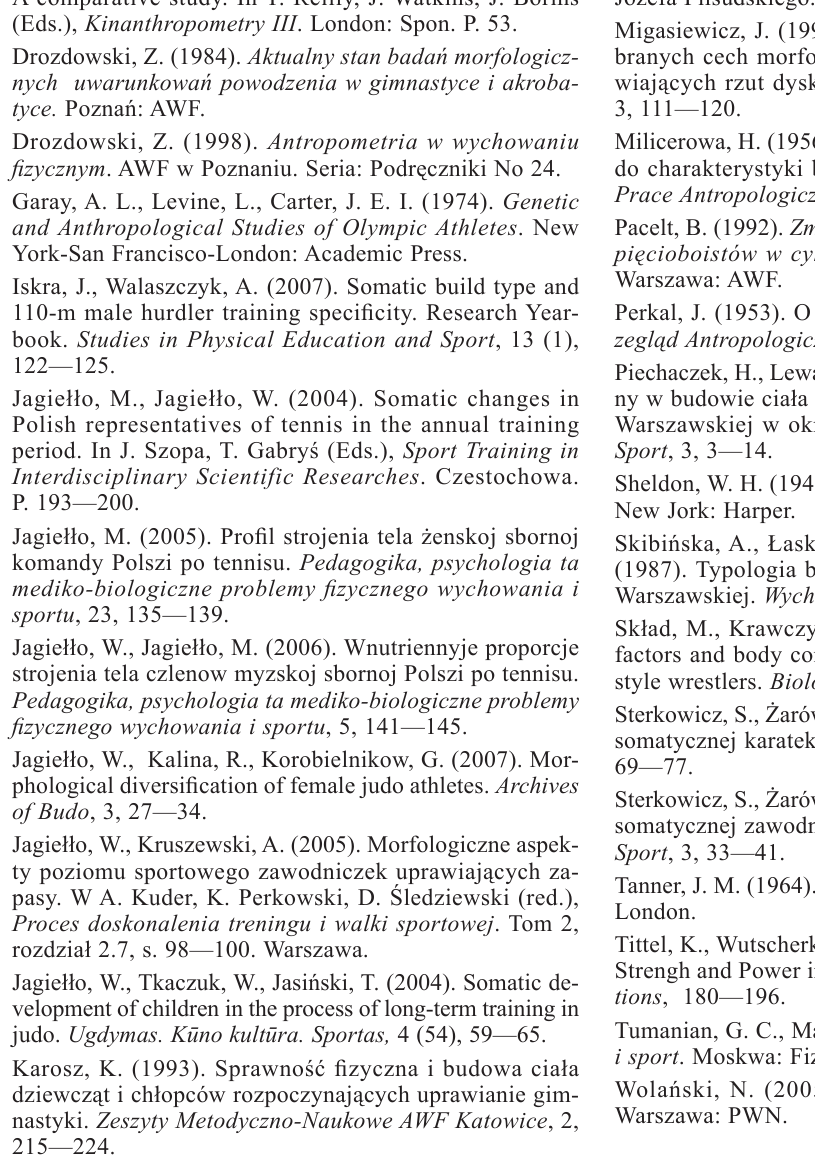
3. Natural indices of the body composition factors indicate internal proportions of female tennis players (6—2—4) in which the total body size is due to high longitudinal body dimensions (6), low indices of stoutness (2) and an average de- gree of obesity (4).